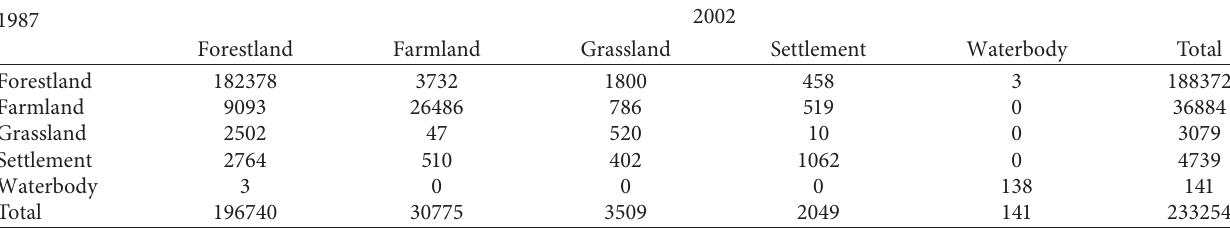
Table 7: Transition area matrix (ha) between 1987 and 2002 in MFBR.